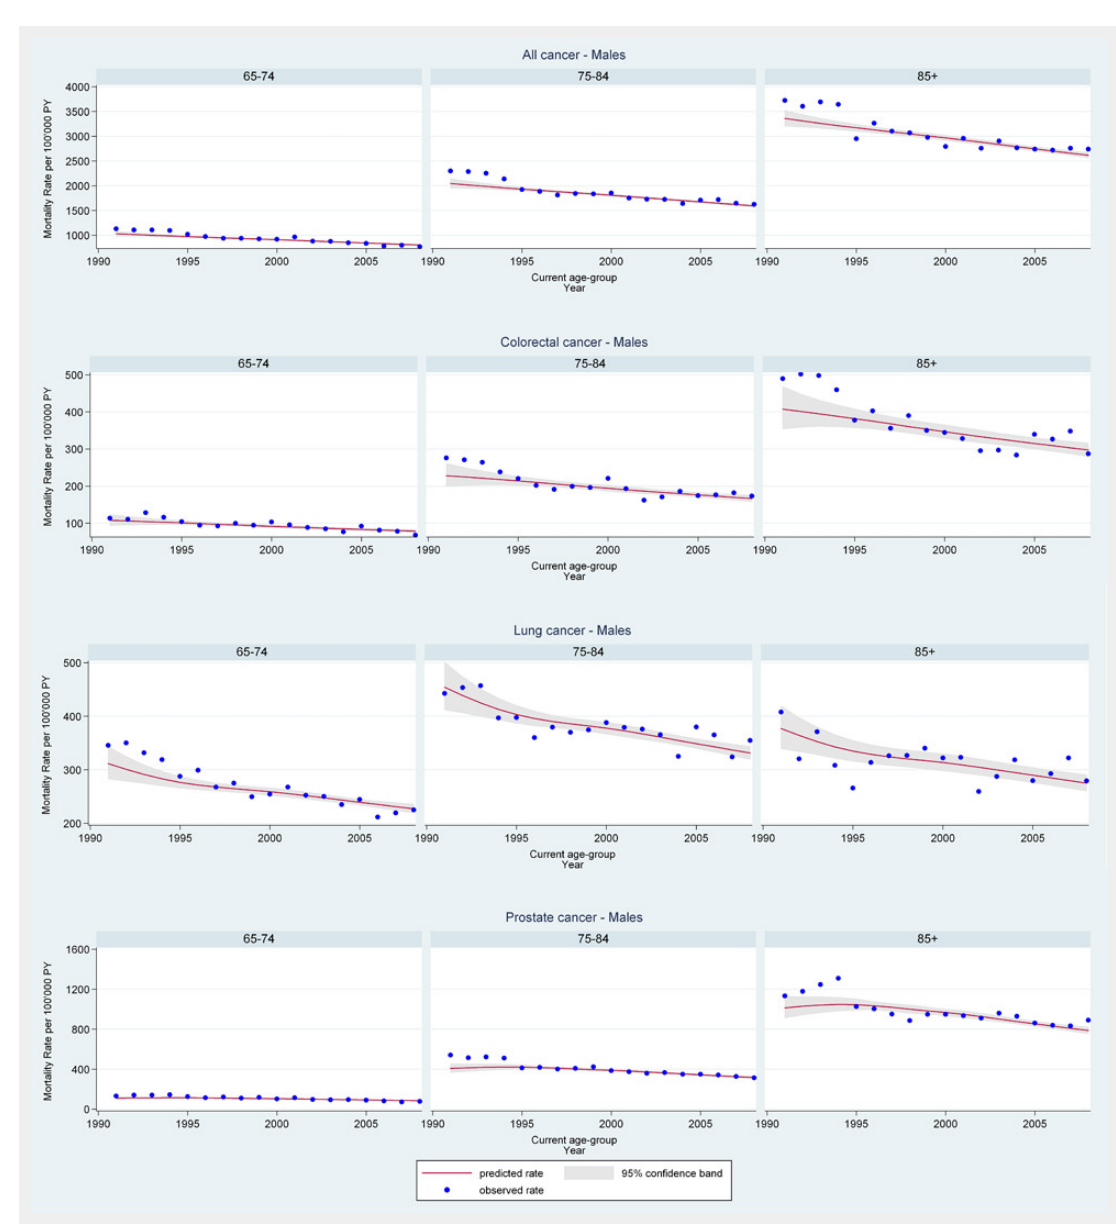
Figure 1 Age-specific cancer mortality from 1991 through 2008 in Swiss men ≥65 years